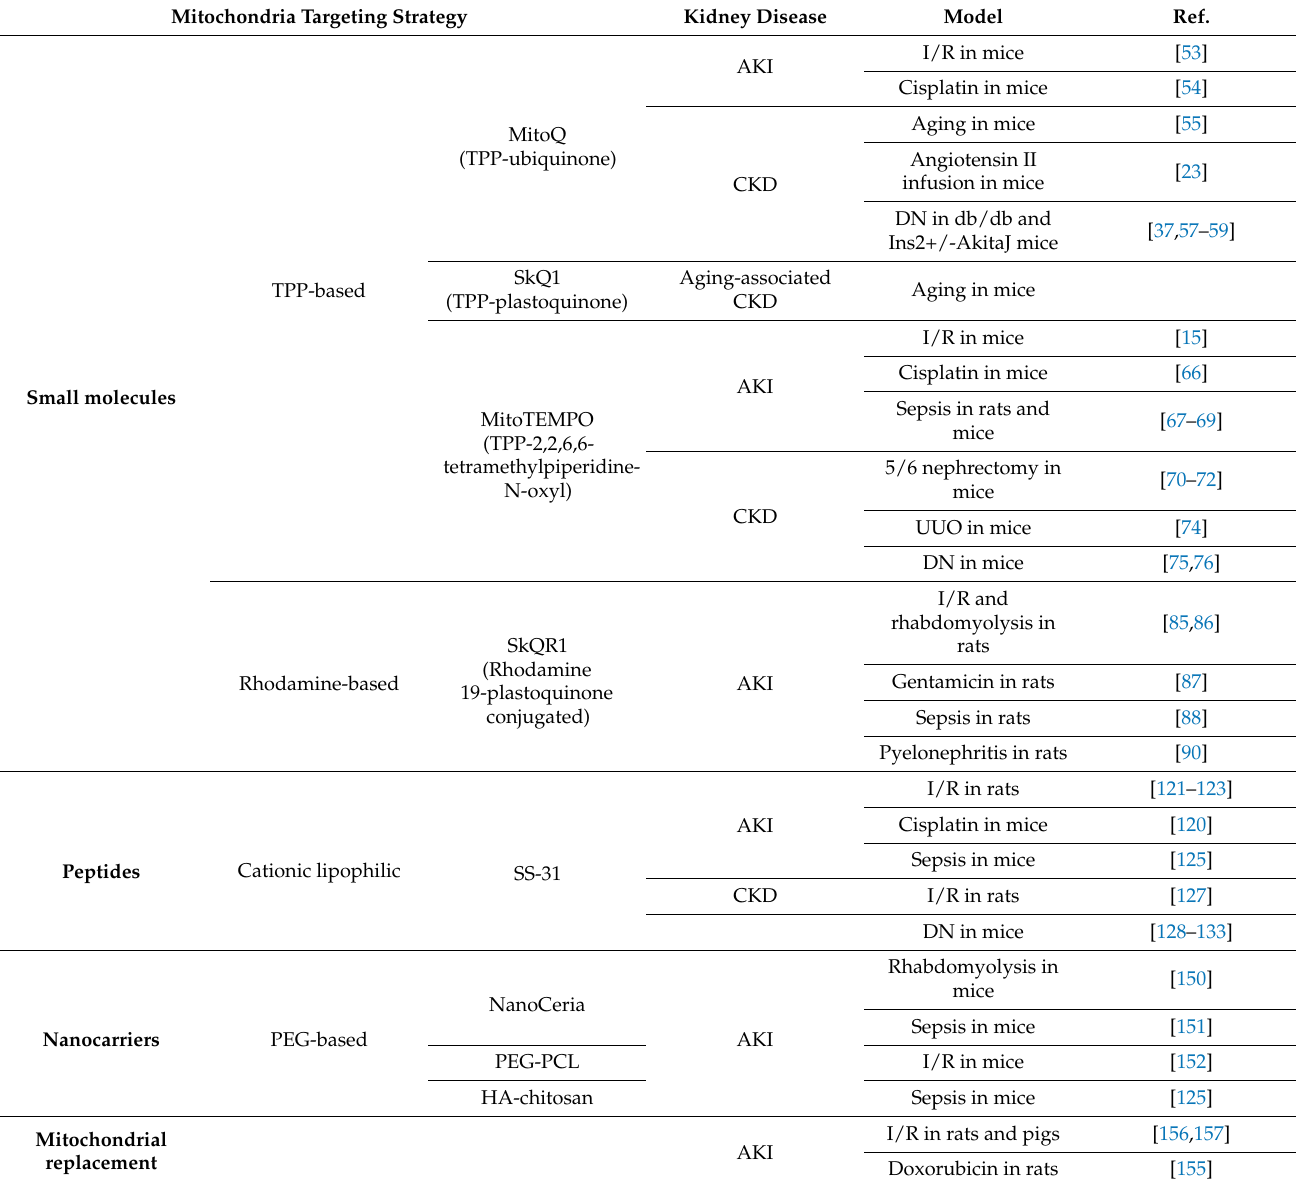
Table 2. Mitochondria targeting strategies tested in kidney disease models.